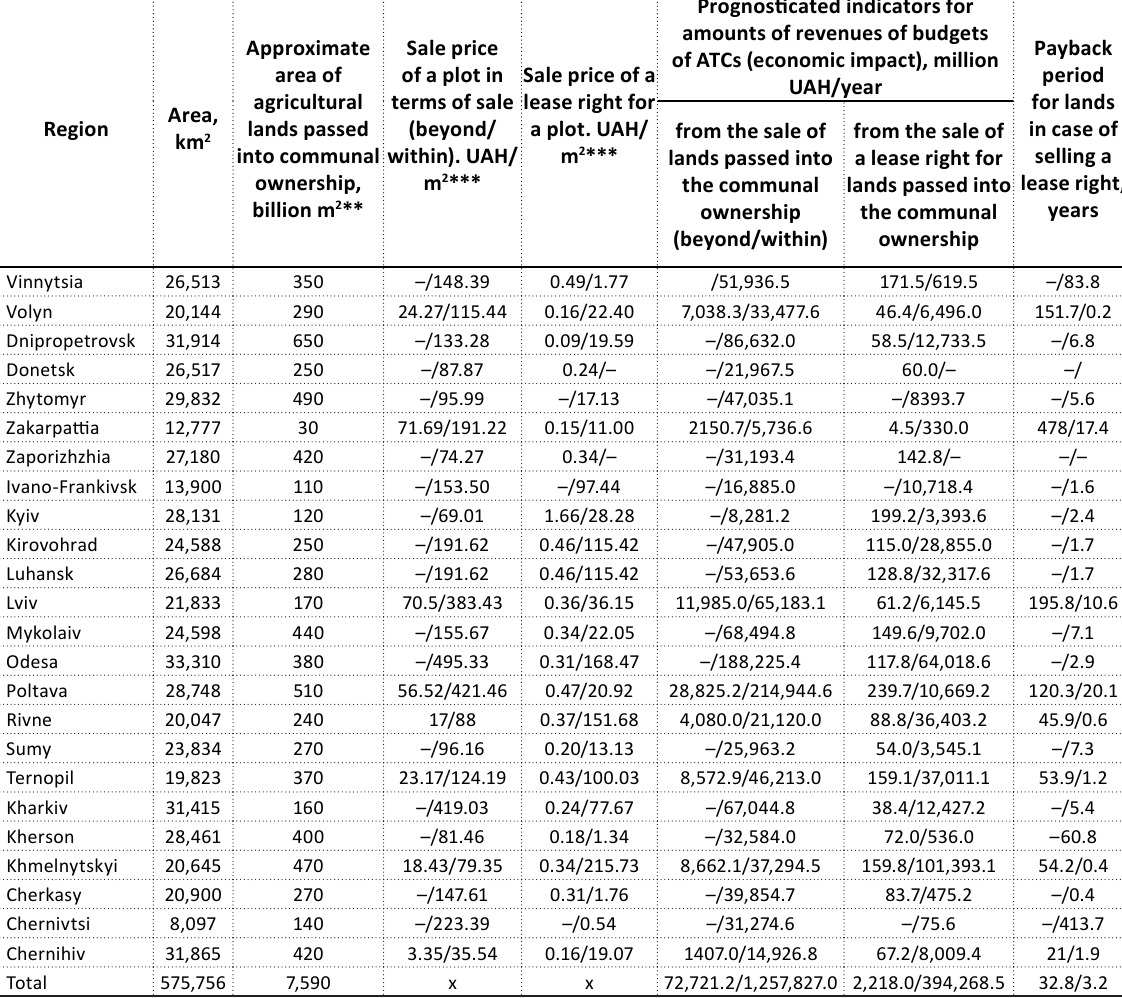
Table 2. Economic efficiency of the use of agricultural land plots in terms of passing them into ownership of perspective territorial communities at the sale price by January 1, 2019 Source: Decentralization Reform (2017), Government Portal (2018), the State Service of Ukraine for Geodesy, Cartography and Cadastre (2018).